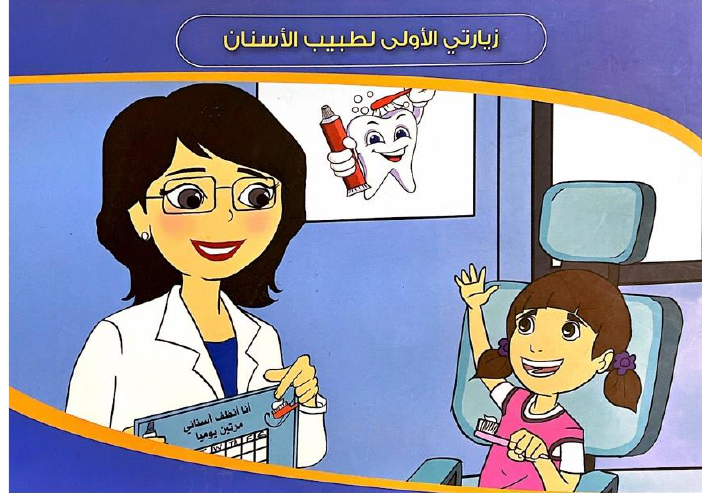
Figure 1. The cover of the book entitled “My First Visit to the